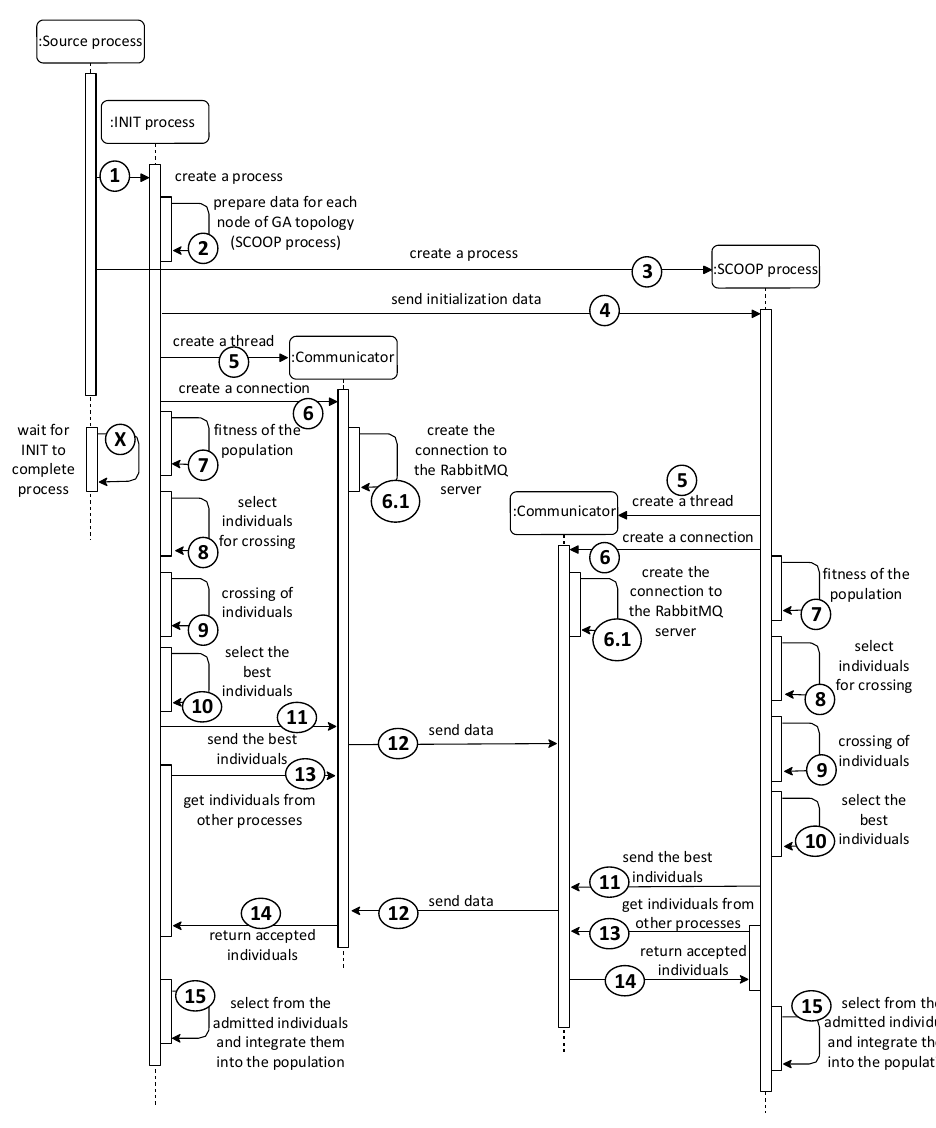
Figure 6. Sequence diagram of one iteration of the Coarse-Grained model for 2